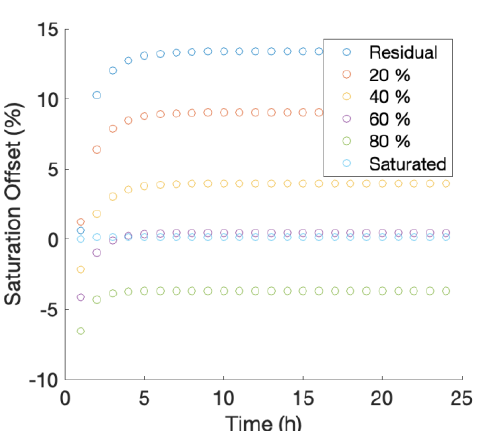
Figure 3. Effect of repeated heat pulses (one cycle per hour, for 24 h) on aFO-DTS accuracy for different saturations. Accuracy, represented by saturation-offset, decreases over the first four heat cycles after which the offset is constant for subsequent heat pulses.